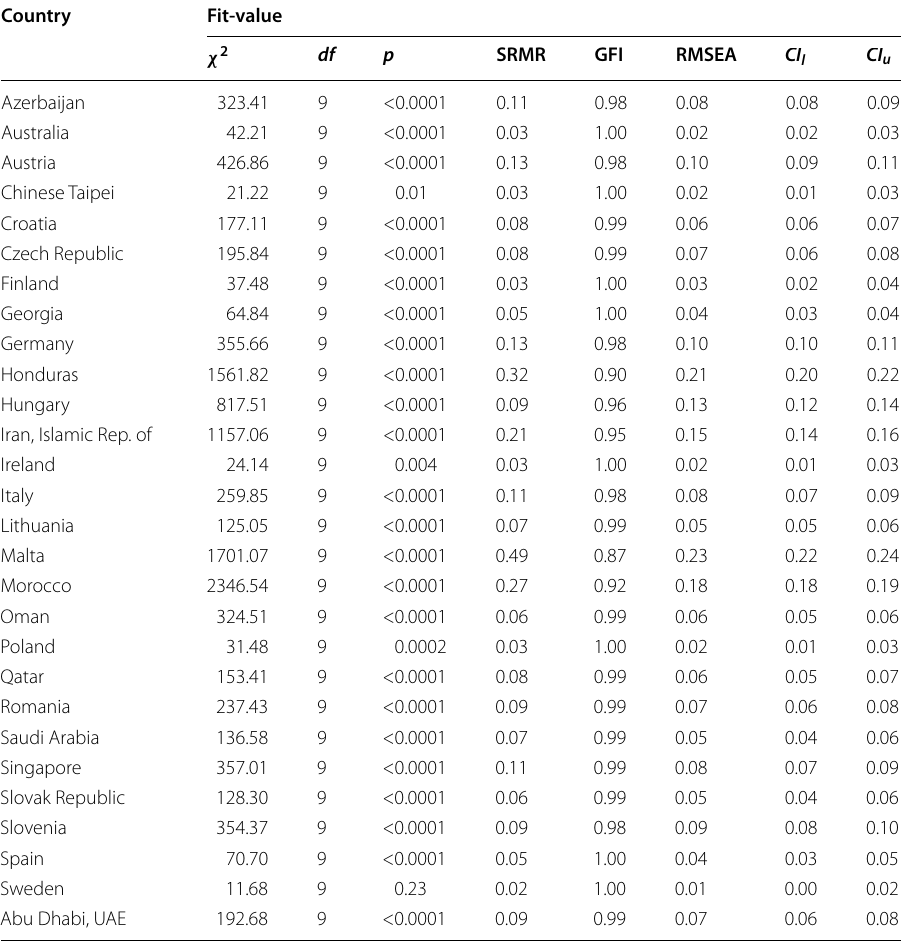
χ 2 , under the null hypothesis of equality of the covariance matrix G gz across scaling models, this value should not be statistically different from zero; SRMR, standardized root mean square residual should be zero under the null hypothesis; GFI, goodness-of-fit index should be one under the null hypothesis; RMSEA, root mean square error of approximation should be zero under the null hypothesis; CI l , CI u , lower and upper bound of